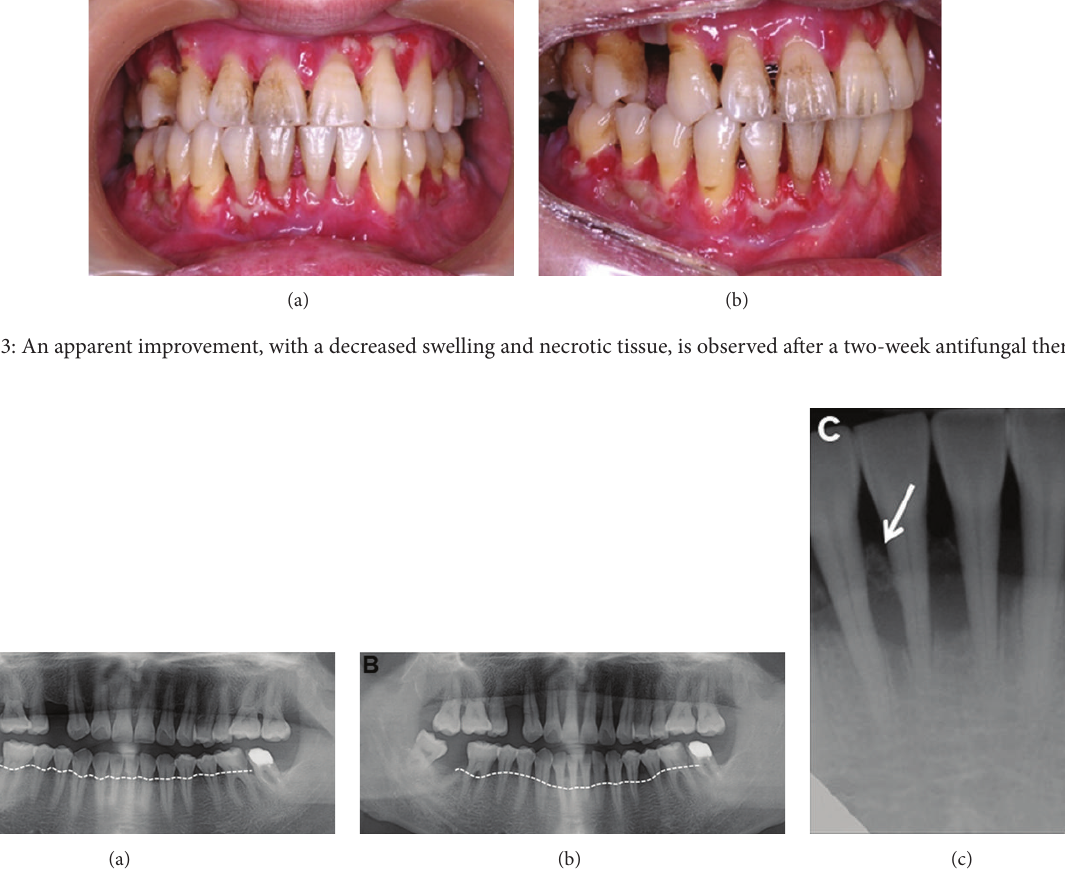
Figure 4: (a) Initial panoramic view (September 2, 2009). The dotted line denotes the marginal bone level. (b), (c) Panoramic and periapical view 2 months after treatment (November 19, 2009). Note the marginal bone loss and the sequestrum at the lower anterior teeth area (arrow). Also note that the radices of the second right lower molar have been removed.